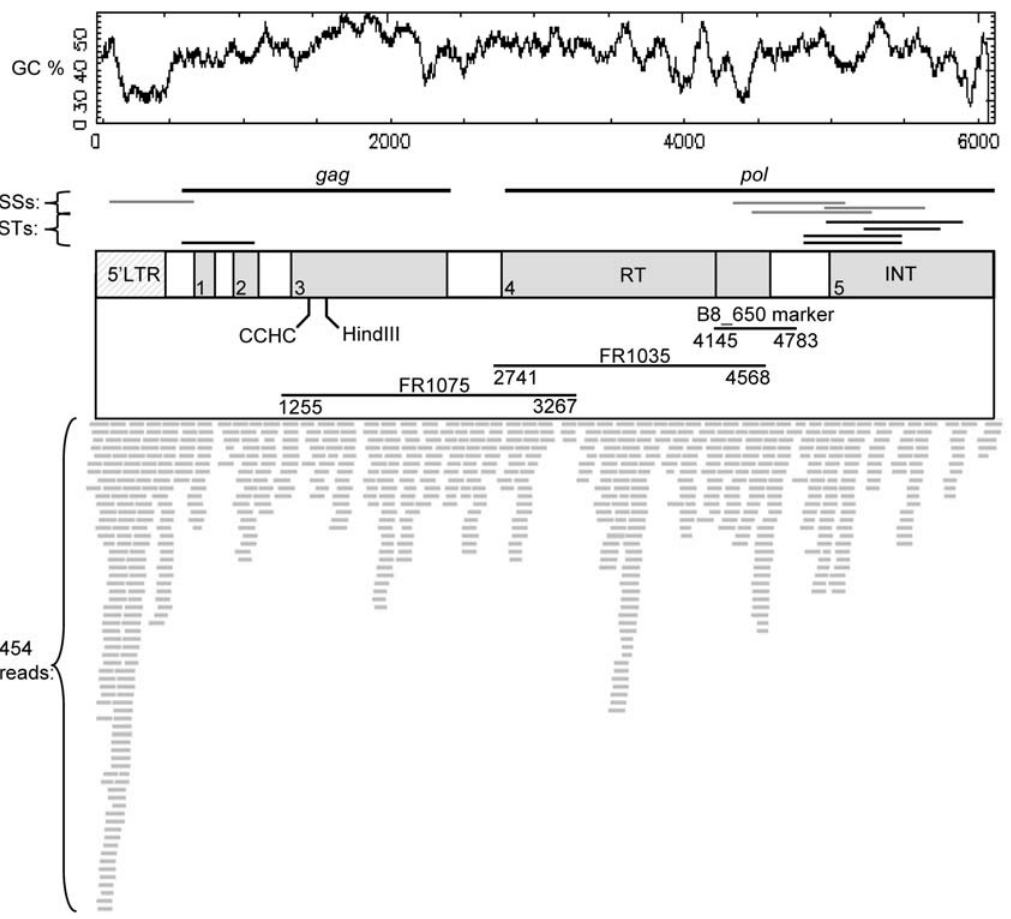
Figure 1. Organization of the RLG_ Gymny _EU912388-1 retrotransposon. Percent G + C is shown above the Gymny schematic. Numbered ORFs are in gray with vertical lines indicating stop codons, putative 5 9 LTR as hatched box, PR protease, RT reverse transcriptase, INT integrase. ESTs, GSSs, and 454 reads are indicated as are the B8_650 marker, and the Southern probes Fr1075 and Fr1035.